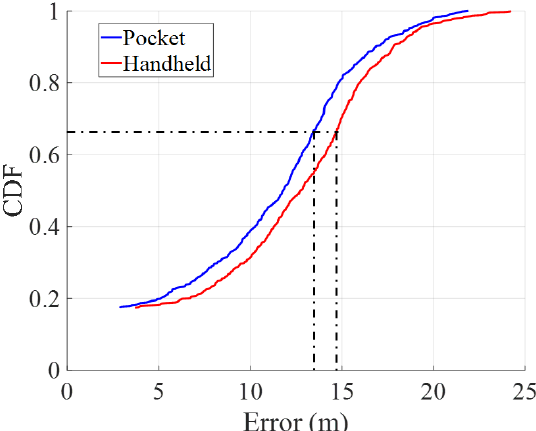
Figure 23. Cumulative density functions of the accumulated error for pocket (blue) and handheld (red) carrying modes without landmark-based position correction.